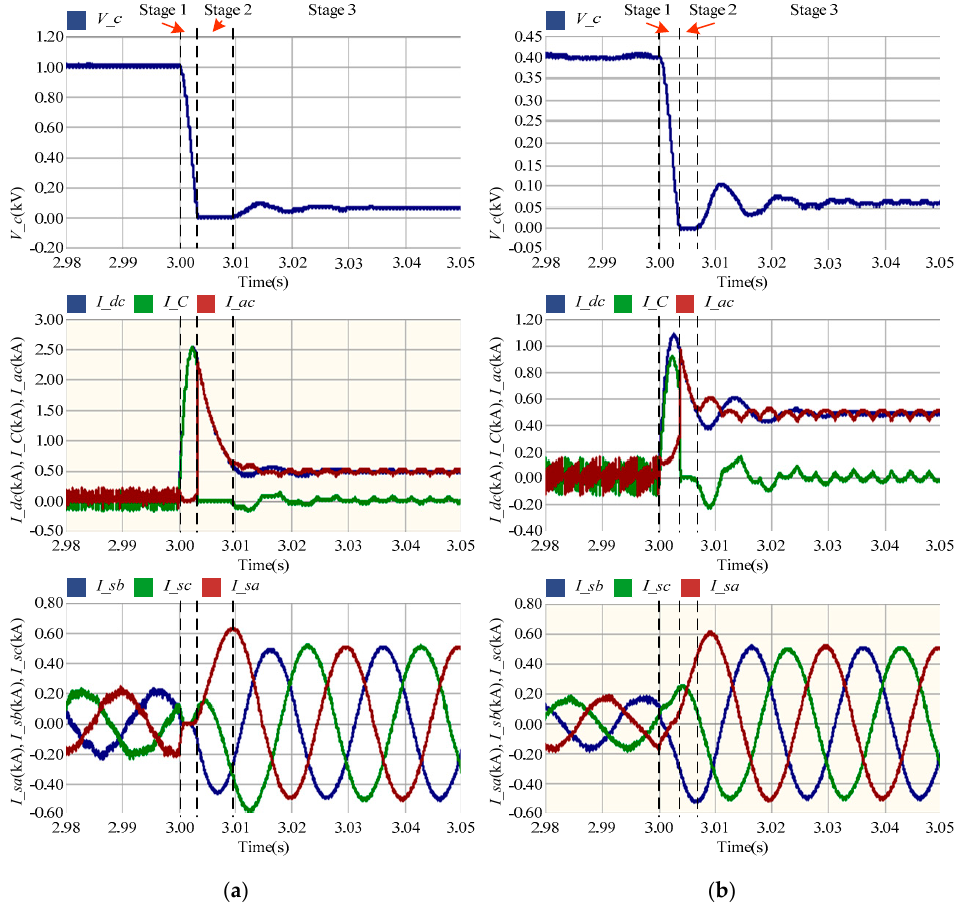
Figure 2. The electrical waveforms of different stages: ( a ) The waveforms in the HVDC system: DC-side voltage V_c (in kV), DC-side current I_dc (in kA), capacitor current I_C (in kA), AC-side feeding current I_ac (in kA), and AC-side three-phase current I_sa,b,c (in kA); ( b ) The waveforms in the LVDC system: DC-side voltage V_c (in kV), DC-side current I_dc (in kA), capacitor current I_C (in kA), AC-side feeding current I_ac (in kA), and AC-side three-phase current I_sa,b,c (in kA).